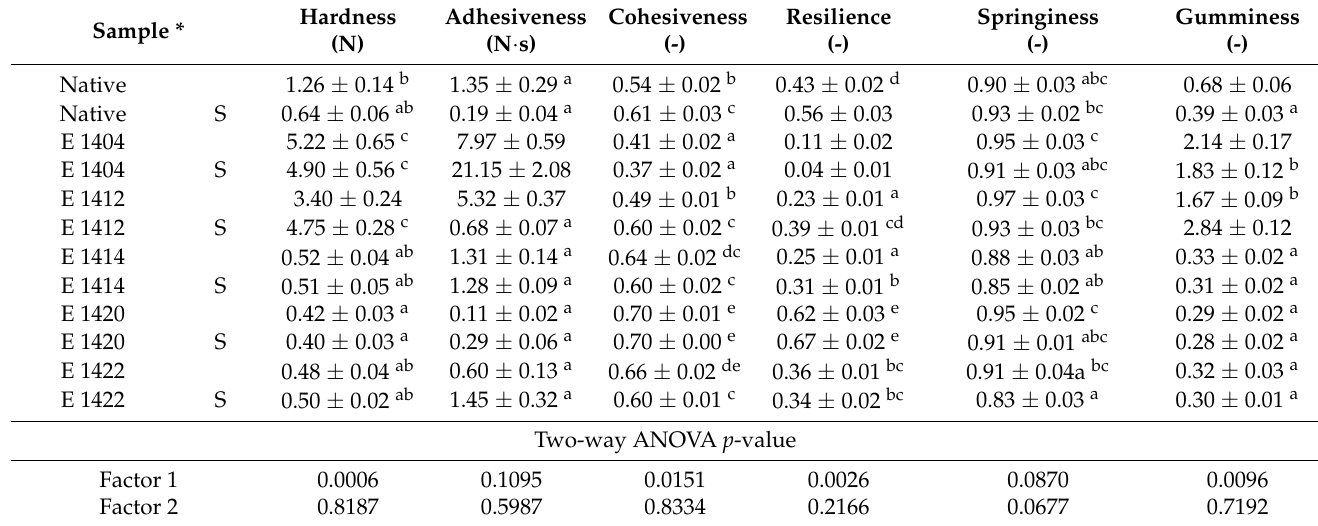
Table 3. Universal texture profile of potato starch